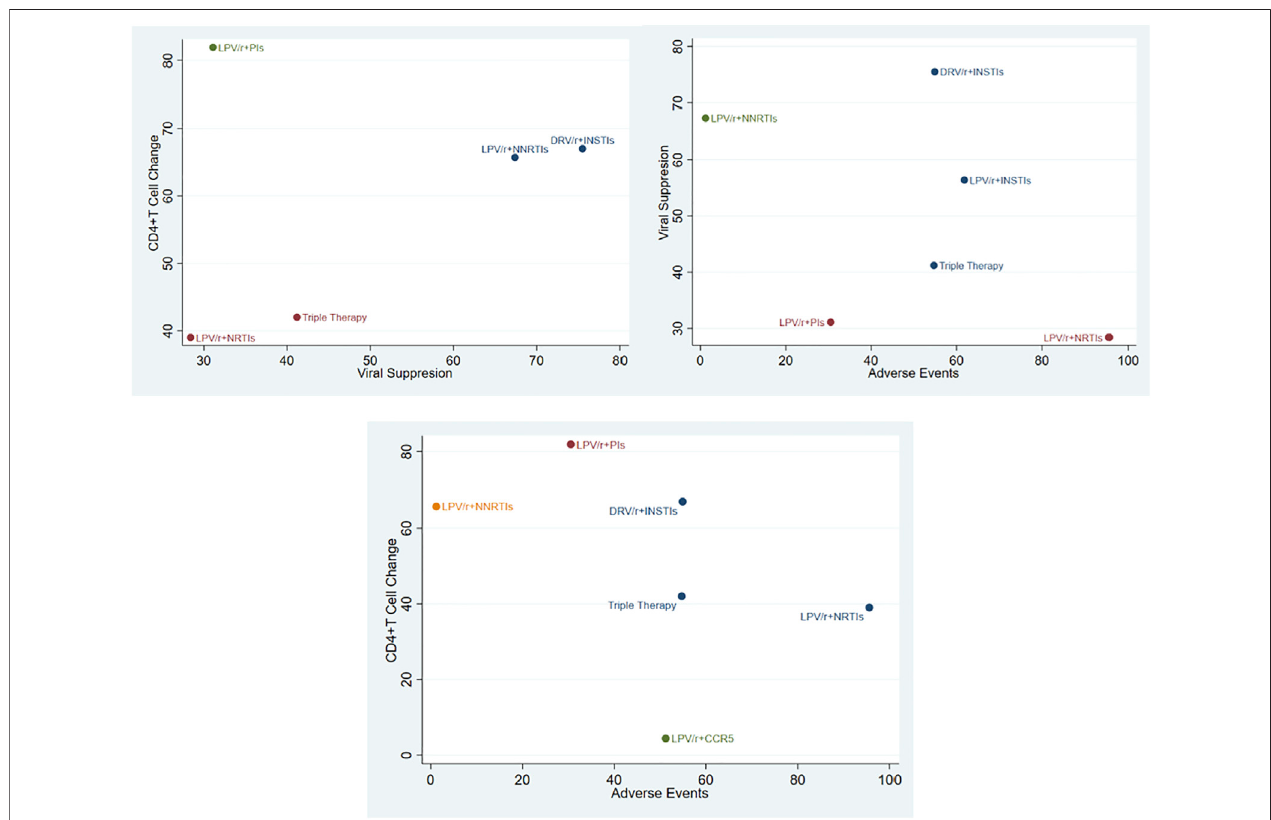
FIGURE 5 | Cluster diagram among different outcome